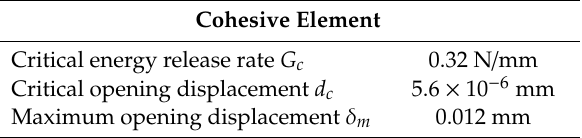
Table 2. Properties of the cohesive interface element.